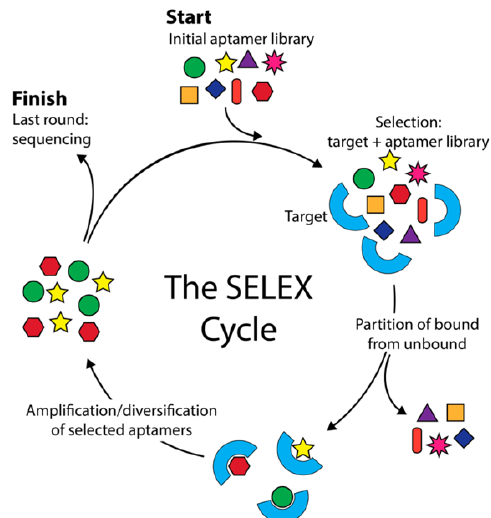
Figure 1. The systematic evolution of ligands by exponential enrichment (SELEX) cycle. SELEX starts with a random nucleic acid aptamer library which is used to initiate the SELEX cycle (top arrow entering cycle). The library is incubated with the target, and the target is washed to remove and discard unbound aptamers (right arrow exiting cycle) before the bound aptamers are eluted and amplified by PCR. The amplified sequences seed the next round of SELEX. Typically, around 12 SELEX cycles are performed before sequencing and aptamer characterization (left arrow exiting cycle). Reproduced with permission of [33] . Copyright 2017 Published by MDPI.